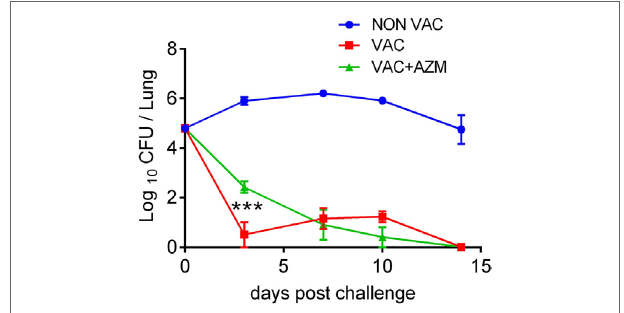
FigUre 4 | Azithromycin (AZM) treatment during immunization attenuates the protective efficacy of a whole cell pertussis (wP) vaccine. Mice were treated with AZM or vehicle during immunization with wP vaccine 6 and 2 weeks before aerosol challenge with Bordetella pertussis . Results are mean ± SEM, CFUs in lung homogenates of four mice per group at each timepoint. Statistical significances were determined via two-way ANOVA followed by Tukey’s multiple comparisons test, only VAC compared to VAC + AZM is indicated, significances for comparison between NON VAC and VAC/VAC + AZM was highly significant (***, not indicated), *** p < 0.001.